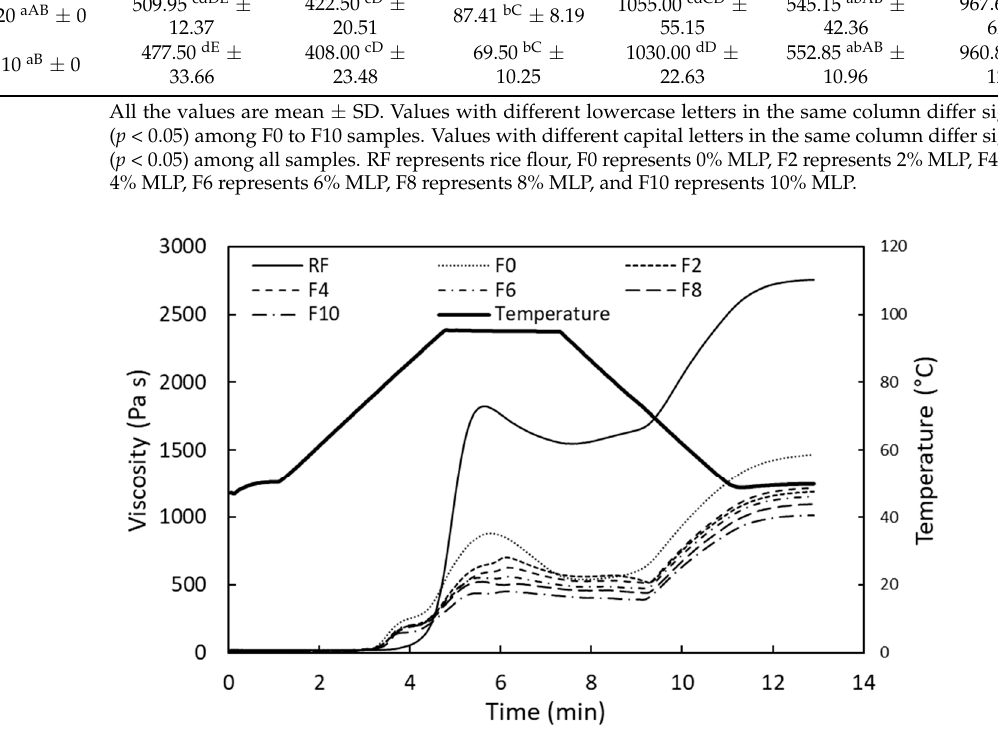
Figure 2 . Pasting curve of RF, F0, and FRN samples. RF represents rice flour, F0 represents 0% MLP, F2 represents 2% MLP, F4 represents 4% MLP, F6 represents 6% MLP, F8 represents 8% MLP, and F10 represents 10% MLP. Table 4. Pasting properties of RF, F0, and FRN samples .